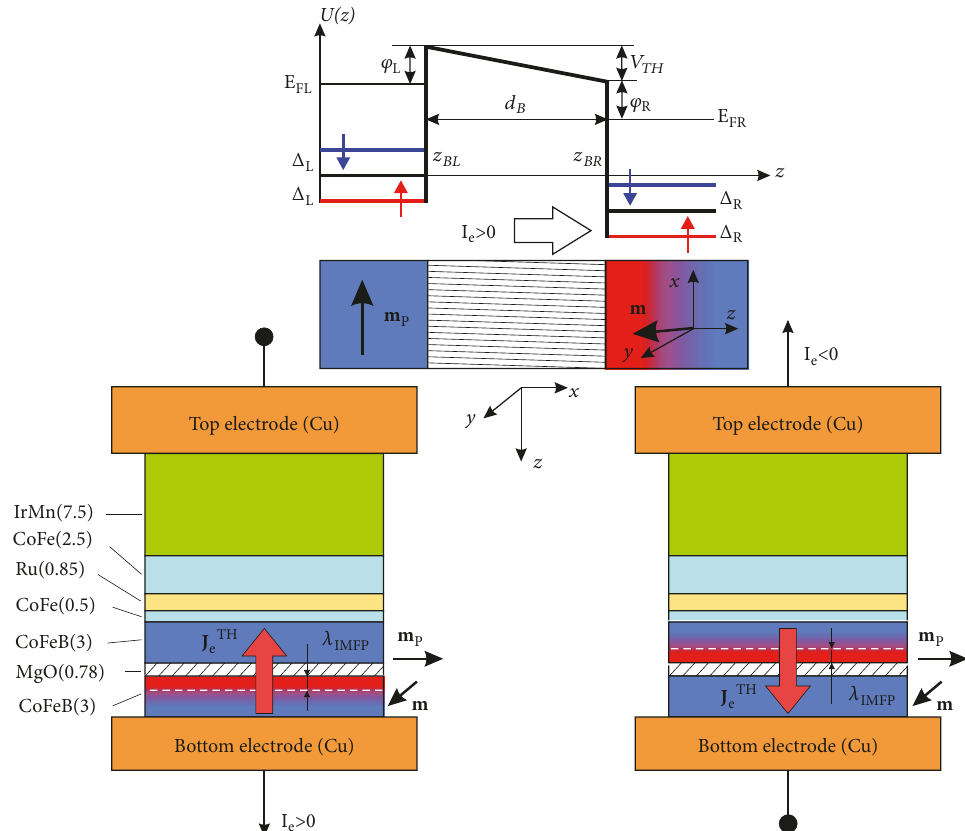
Figure 1: Schematic energy diagram for the potential profile 𝑈(𝑧) of the CoFeB/MgO/CoFeB structure in the MTJ (top) and the heat dissipation along the MTJ under the microwave current 𝐼 𝑒 passing through it (bottom). The red arrow shows the heat flux J TH e due to the inhomogeneous Joule heating of the MTJ when the power is generated close to the right (left) from the boundary of the tunnel barrier at the mean free path 𝜆 𝐼𝑀𝐹𝑃 in the corresponding ferromagnetic layer, depending on the direction of the external current. The thicknesses of the layers in the MTJ stack are in